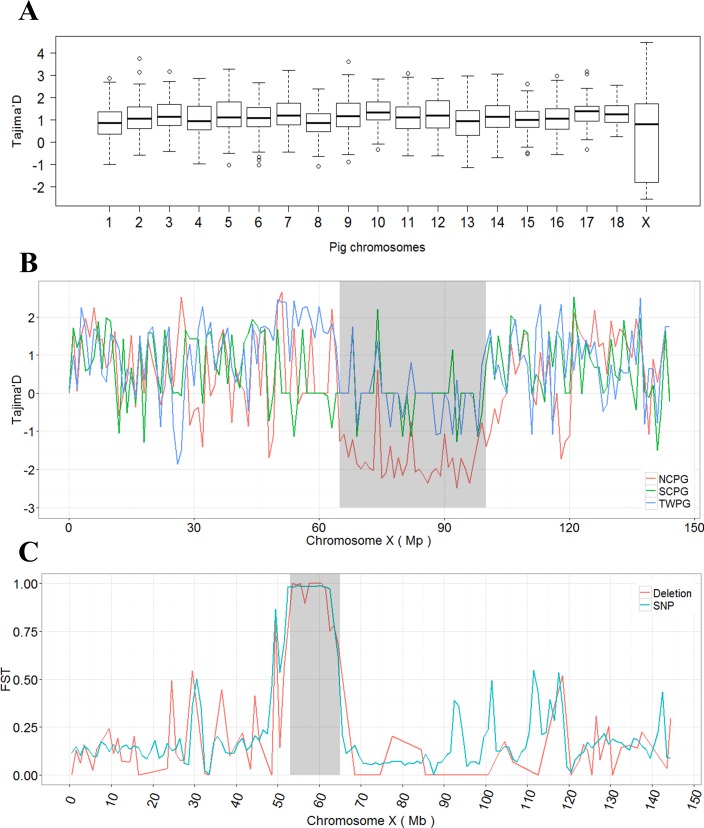
Tajima'D value and FST show a selective sweep of deletion on chromosome X in Chinese pigs.(A) Tajima’D values of deletions on different chromosomes. (B) Tajima’D values of deletions on chromosome X in NCPG, SCPG, and TWPG groups. The gray region represents the Chinese pig-specific SV region (65 to 100 Mb region on chromosome X), where the NCPG shows a continuous negative status. (C) Fst values of deletions and SNPs in the comparison of NCPG and SCPG. The gray region stands for the most significantly differentiated block (53 Mb-65 Mb on chromosome X) between the NCPG and SCPG.